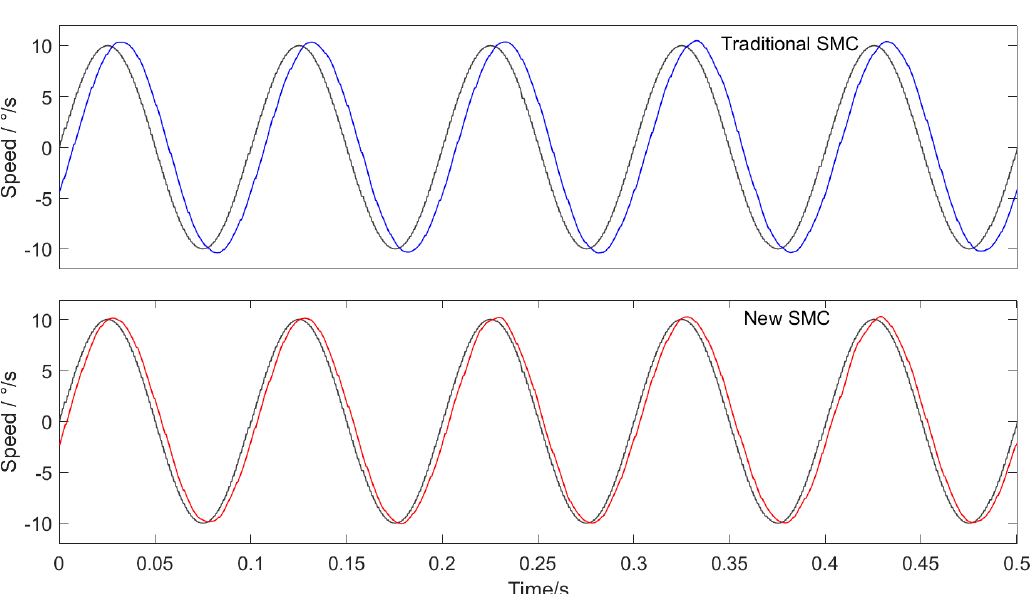
Figure 8. Tracking curve of sine wave.